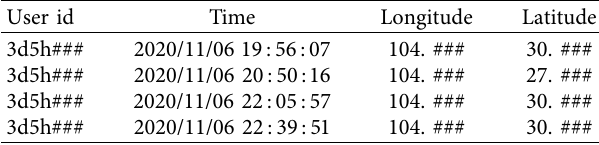
Table 2: Example of timing report